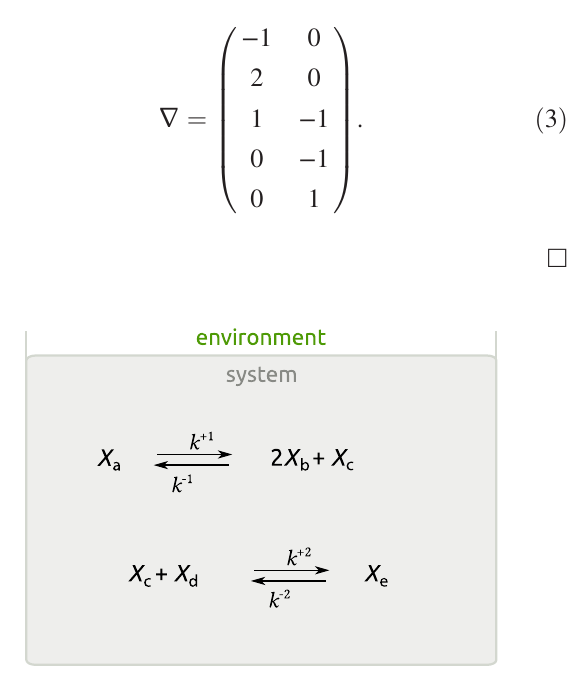
FIG. 1. Representation of a closed CRN. The chemical species ; … ; X are f X . The two reaction pathways are labeled by 1 and a e g 2. The nonzero stoichiometric coefficients are − ∇ a 2 , and ∇ c 1 for the first forward reaction and ∇ b − 1 ¼ − 1 ¼ − ∇ c ¼ − 1 , − ∇ d ¼ − 1 , and ∇ e − 2 ¼ 1 for the second one. þ 2 þ 2 Since the network is closed, no chemical species is exchanged with the